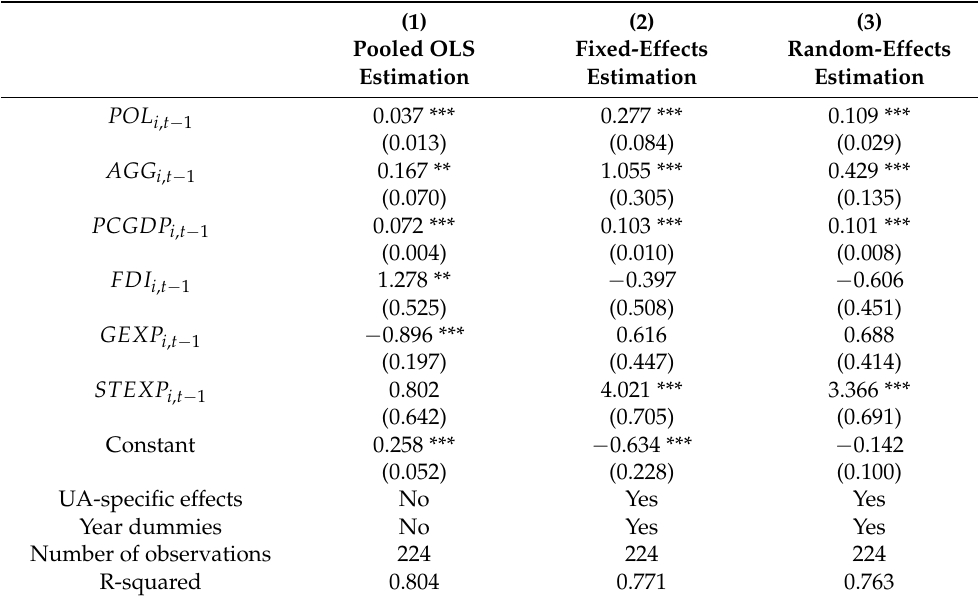
Table 2. Estimation results of the baseline model of determinants of GUEUL.